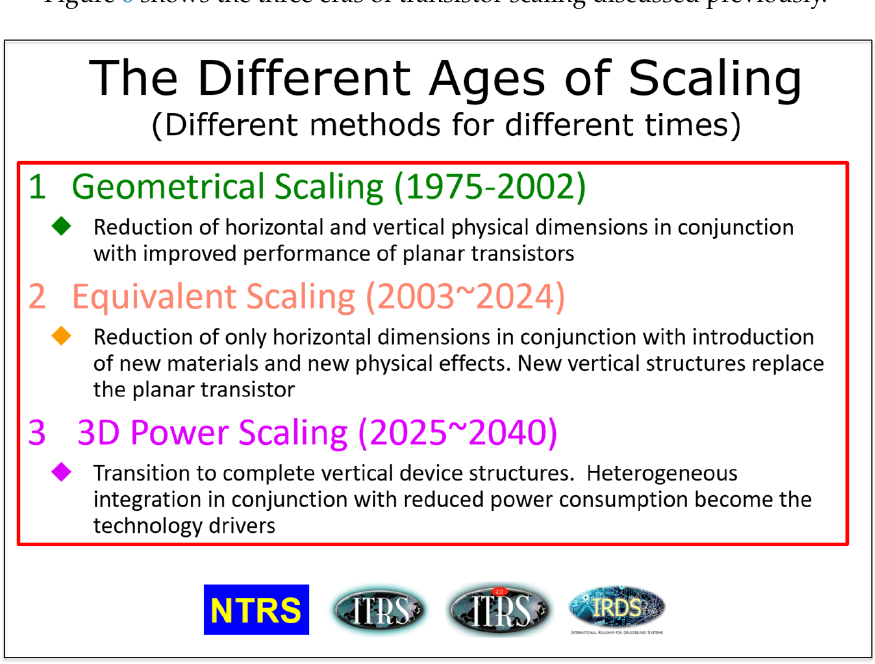
Figure 6. The 3 eras of transistor scaling highlighted by NTRS, ITRS, ITRS 2.0, IRDS.